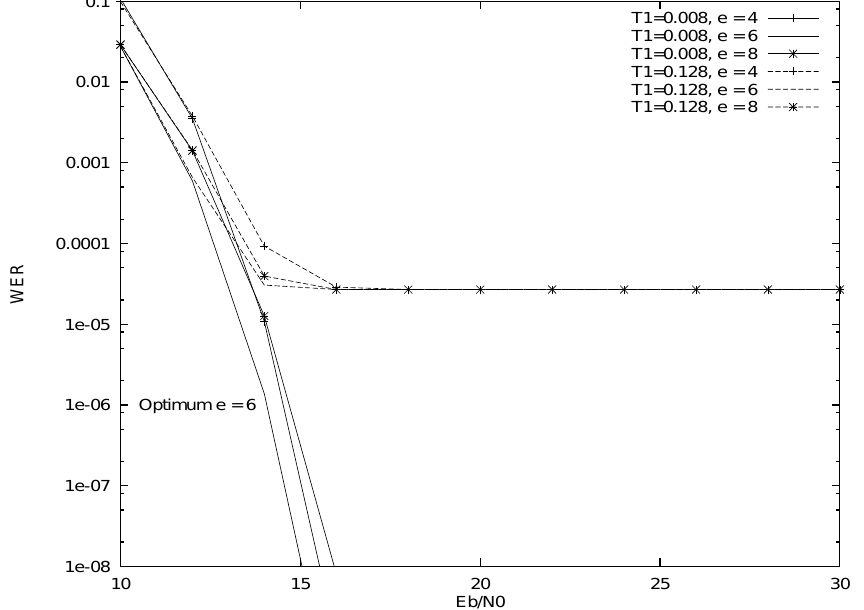
Figure 4. WER vs. E b / N 0 for truncated channel inversion with ordering and comparing a